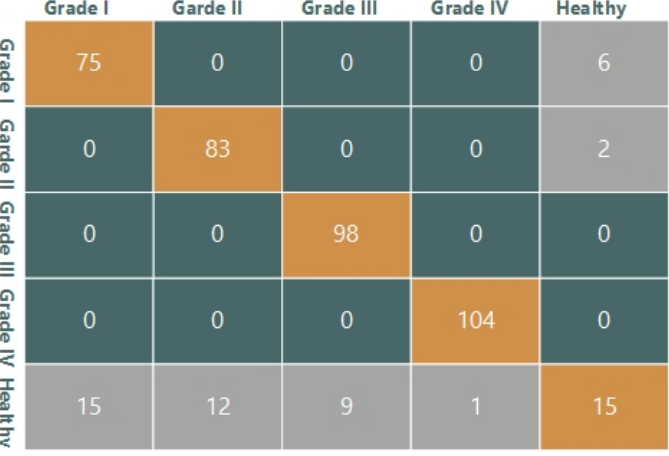
Figure 8. Detailed Confusion Matrix for